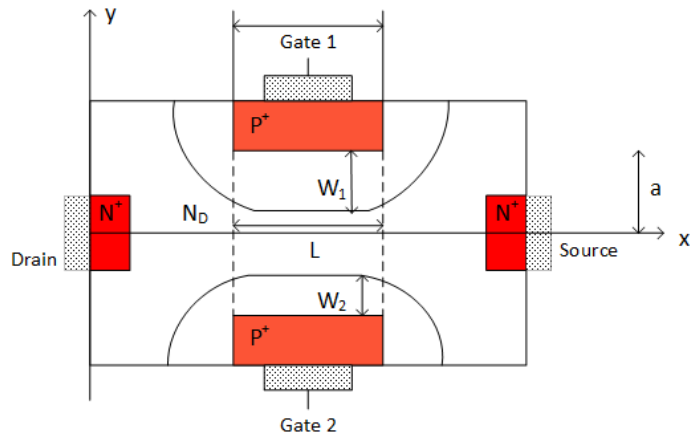
Figure 2. Channel structure of the SiC LC-VJFET investigated device.